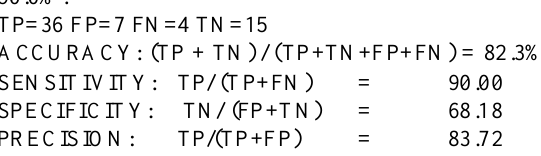
Figure 4. Confusion Matrix of Proposed Classification, using PCA-Based for Classification True Positive Rate 68.2% and False Negative Rate yields